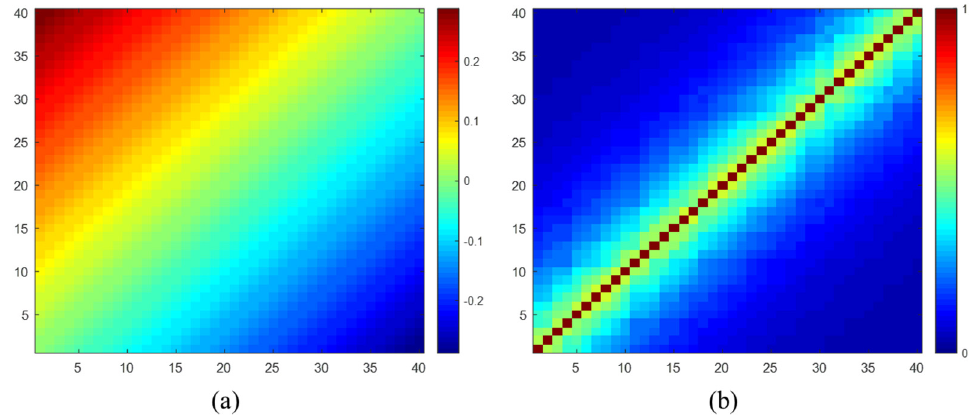
Figure 4. True data of ( a ) interferometric phase matrix and ( b ) coherence magnitude matrix. The values of s with a window of 5 5